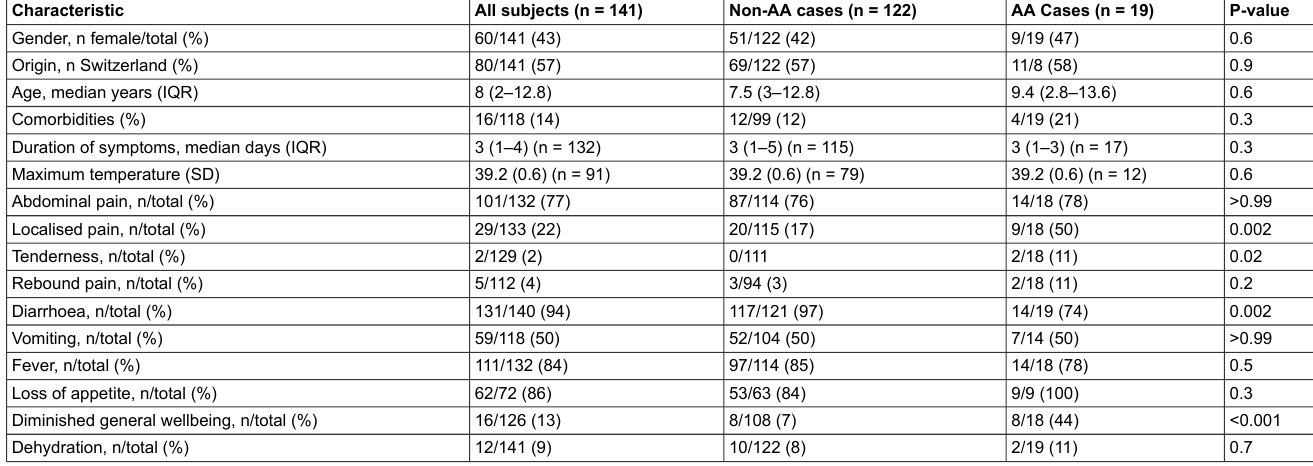
Table 1: Clinical and demographic characteristics of the study